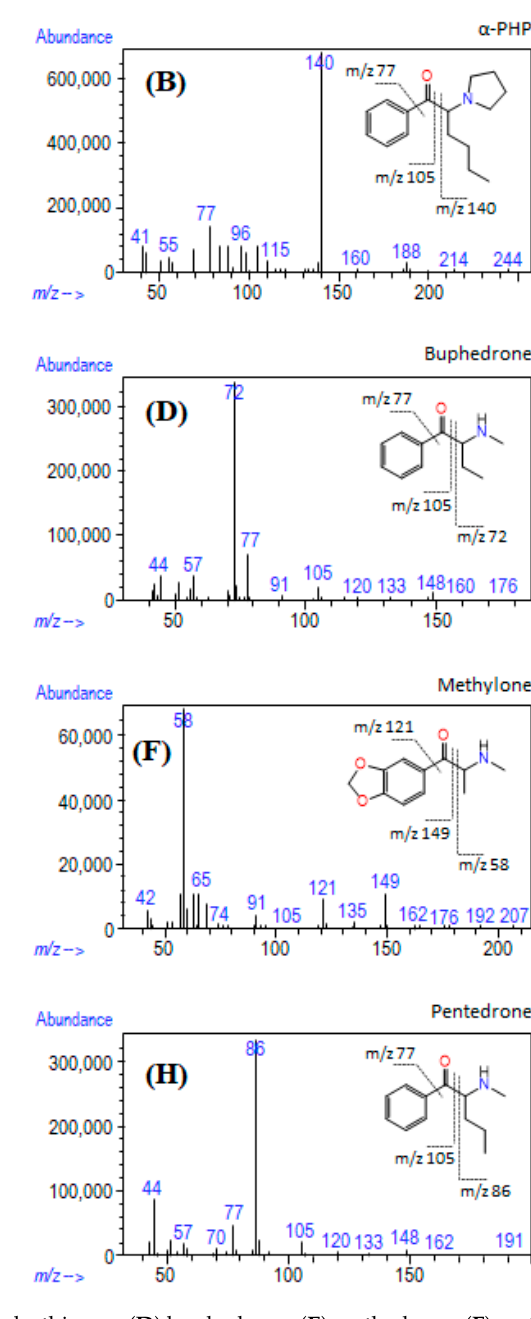
Figure 3. EI mass spectra of ( A ) MPHP, ( B ) α -PHP, ( C ) N -ethylcathinone, ( D ) buphedrone, ( E ) methedrone, ( F ) methylone, ( G ) 3-FMC and ( H ) pentedrone found in seized products.